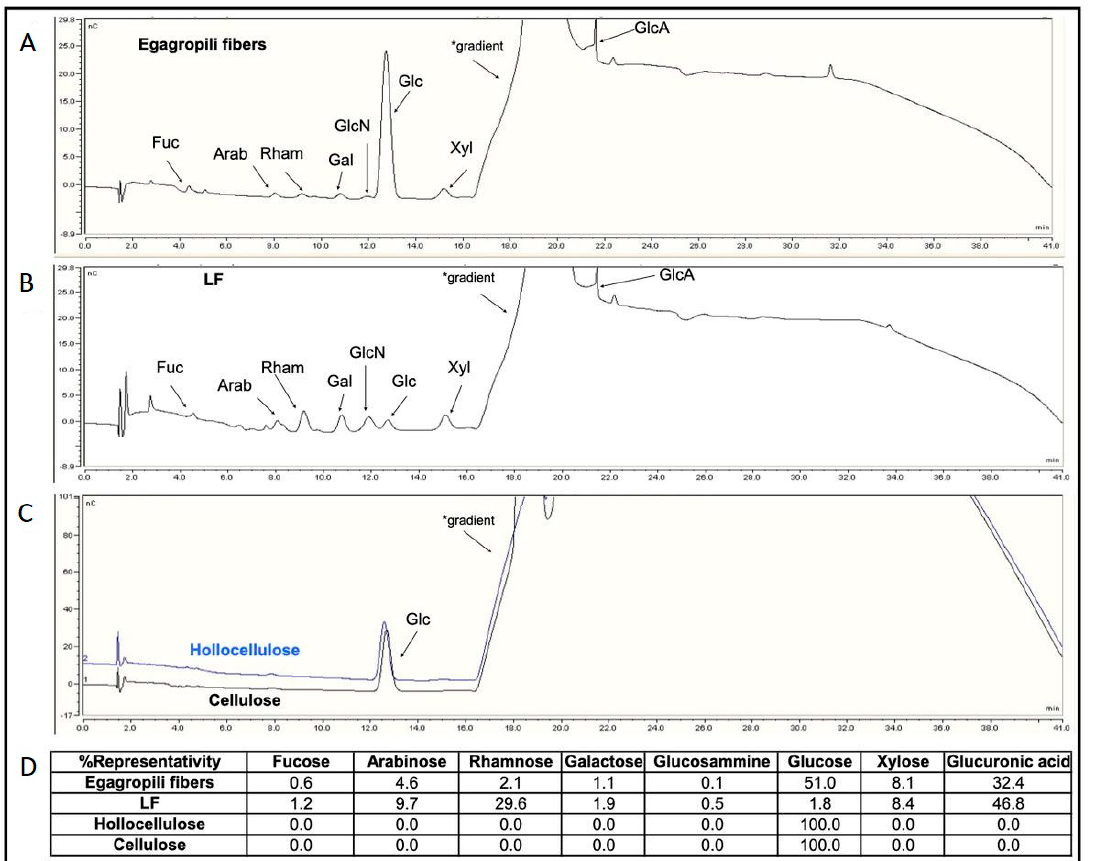
Figure 5. High-performance anion-exchange chromatograms of egagropili fibers ( A ), lignin fraction (LF) ( B ), hollocellulose and cellulose samples ( C ). The different monosaccharide peaks are indicated by the arrows. The representativity percentage of each monosaccharide is reported in the panel ( D ). * Increasing concentration of NaOH used as eluent. Further experimental details are given in the text.